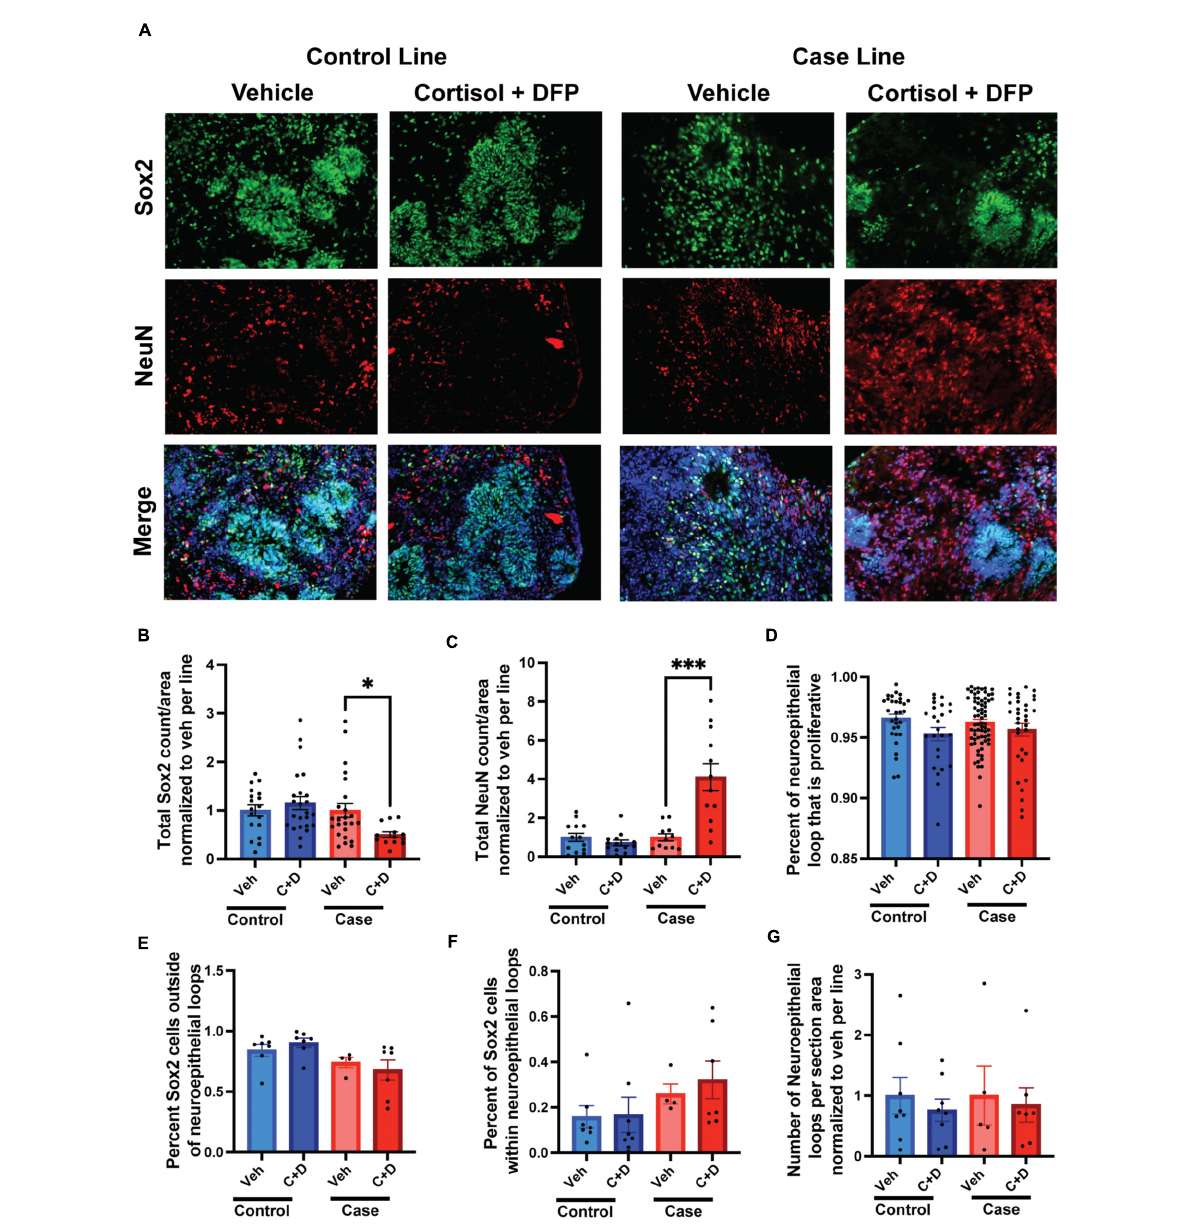
FIGURE5 Gulf War (GW) toxicant exposure alters neurogenesis in forebrain cerebral organoids. (A) Representative immunofluorescence images from one control line and one case line exposed to 2 µ M cortisol plus 200 nM diisopropyl fluorophosphate (DFP) show staining for the neuroprogenitor cell marker Sox2 (green), the neuronal marker NeuN (red), and 4, 6-diamino-2-phenylindole (DAPI) (blue). (B,C) These graphs show the counts of Sox2 cells decreased in the case line by 53.77% (0.5377 ± 0.0595) and the counts of NeuN cells increased in the case line by 310% (3.1 ± 0.6912) across the organoid sections normalized to vehicle per line. (D) This graph shows the size of the progenitor zone in the control line and case line, although there is no significant difference. (E,F) These graphs show the distribution of Sox2 positive cells associated or non-associated with a neuroepithelial loop. (G) This graph shows the number of neuroepithelial loops per organoid section normalized to vehicle per line. ∗ p < 0.05, ∗∗∗ p <